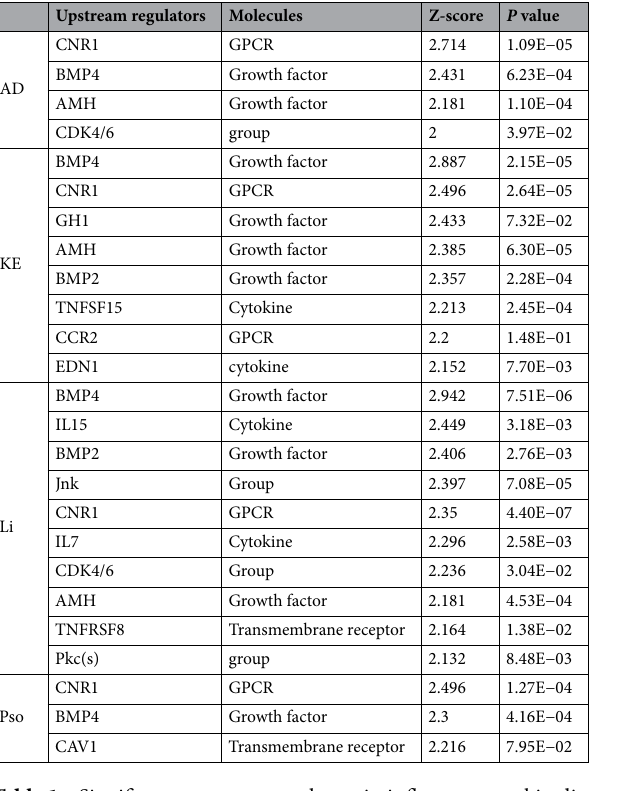
Table 1. Significant upstream regulators in inflammatory skin diseases. AD; atopic dermatitis, KE; contact eczema, Li; lichen planus, Pso; psoriasis vulgaris, GPCR; G protein-coupled